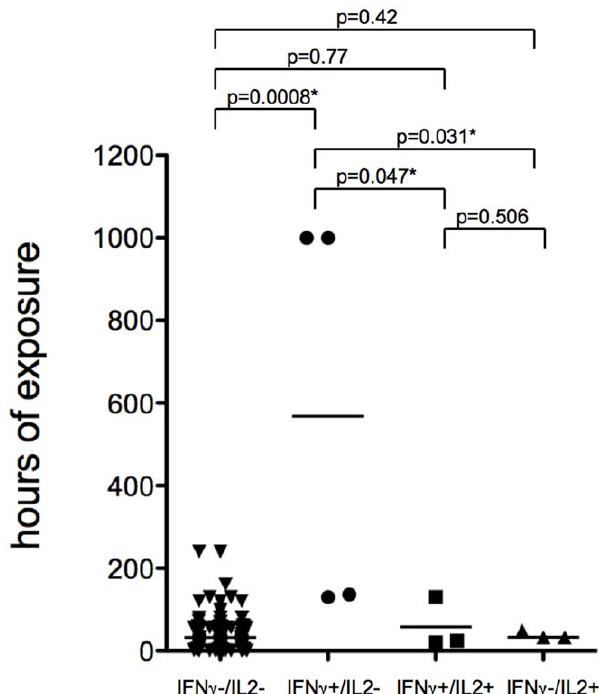
Figure 3. Results of M. tuberculosis specific enzyme linked immunospot (ELISpot), assaying interferon (IFN)- c